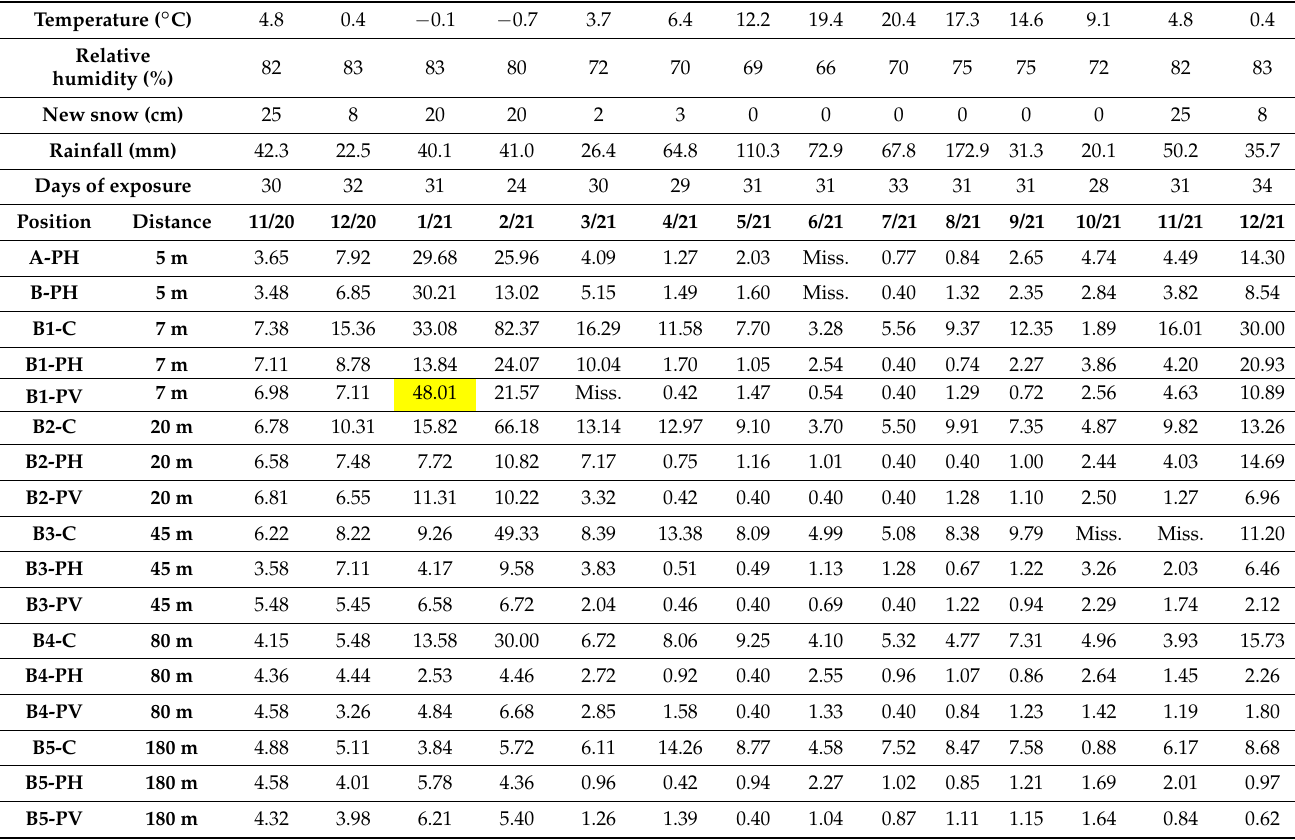
Table 2. Average monthly value of deposition chloride ions (mg/m 2